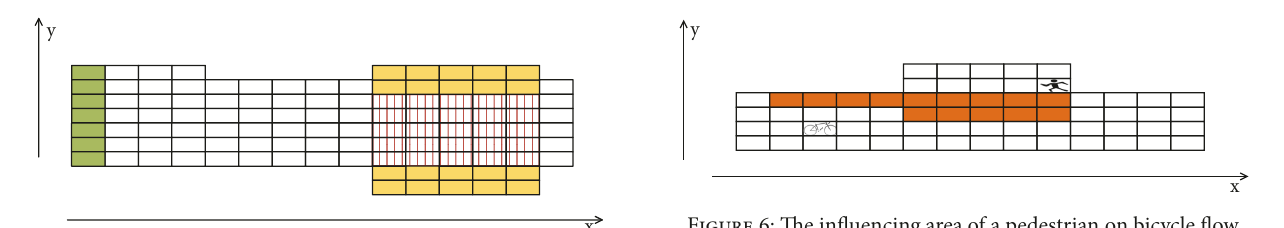
basic movement schematic and the definition of speed above.